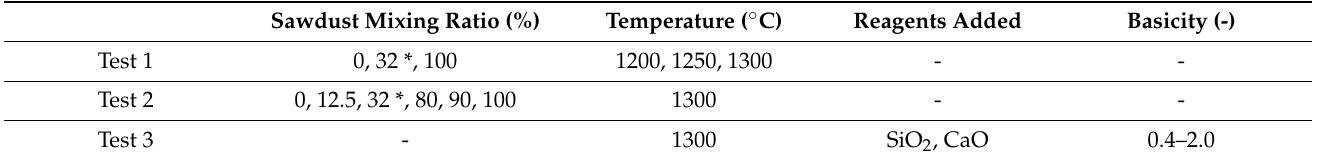
Table 1. Pouring index test experimental